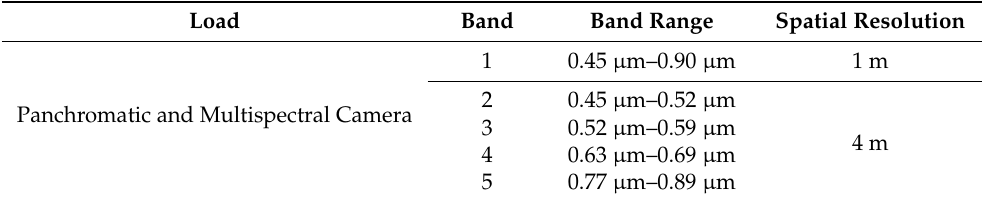
Table 1. Spectral bands of the GF-2 satellite. Load Band Band Range Spatial Resolution